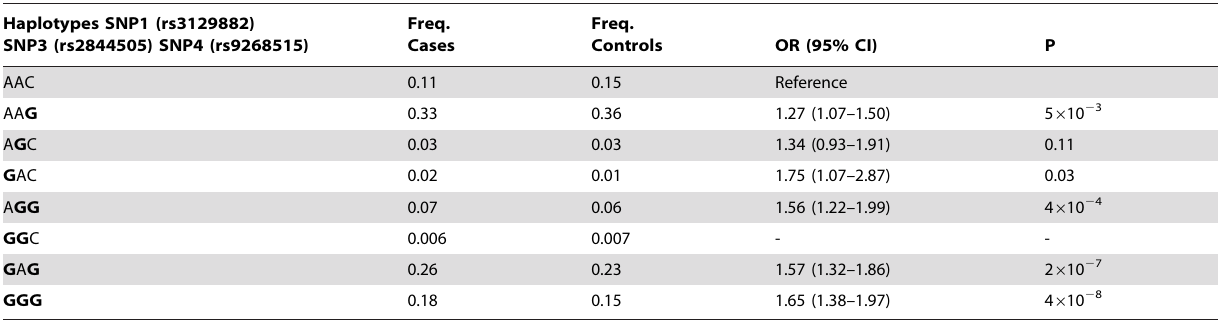
Table 3. Haplotype analysis.